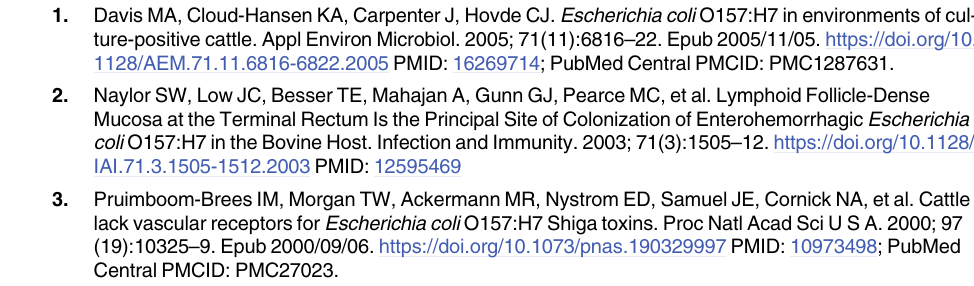
S3 Fig. Vaccination of calves induced E . coli O157:H7-specific serum IgG. The serum IgG induced after vaccination was determined by reacting 10-fold serial dilutions of serum of each of the four calves from Vx -Ch, Vx -Ch, NonVx-Ch, and pooled sera of the four calves of E C NonVx-NonCh groups to the E . coli O157:H7 vaccine strain NADC 6597. Serum IgG levels are represented as Mean ± SD (shown as bars) of three replicate wells of the serum samples. Statistical analysis was performed using one way-ANOVA with multiple comparison of means.